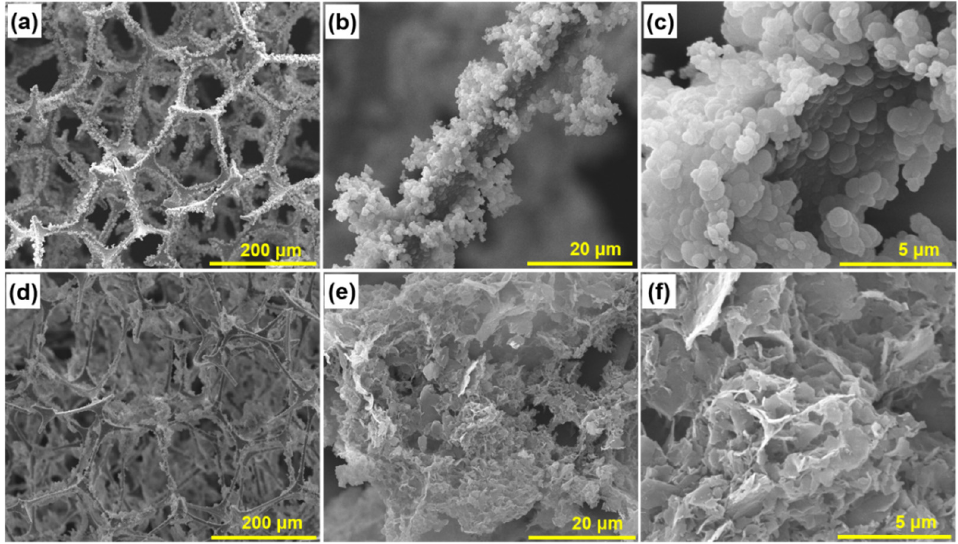
Figure 1. SEM images of MF/PmPD ( a – c ) and MF/Ti 3 C 2 T x /PmPD ( d – f ). The element distribution of C, N, O, S and Ti was analyzed to judge the uniformity of Ti 3 C 2 T x /PmPD on the MF skeleton. The N element was from the MF and PmPD, the Ti element was from the Ti 3 C 2 T x , and the S element was from the Na 2 S 2 O 8 in the oxidative polymerization process. As seen from Figure 2, Ti, N and S had obvious element distribution on the MF skeleton, indicating that the Ti 3 C 2 T x /PmPD realized the effective payload on the MF skeleton [44].